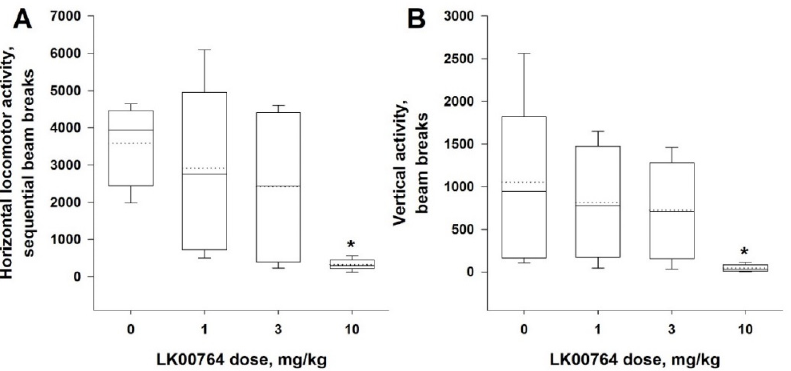
Figure 6. Effect of compound 62 (LK00764) locomotor activity of DAT ‐ KO rats. Administration of compound 62 (LK00764, 1–10 mg/kg, i.p.) decreased both horizontal ( A ) and vertical activity ( B ) of DAT ‐ KO rats. Data are represented as medians (solid lines), means (dotted lines), and 25 th and 75 th percentiles in a box ‐ whisker plot, with whiskers indicating 10 th and 90 th percentiles. * p < 0.05 (Dunnett’s test) compared to vehicle ‐ treated rats (n = 9 per group).